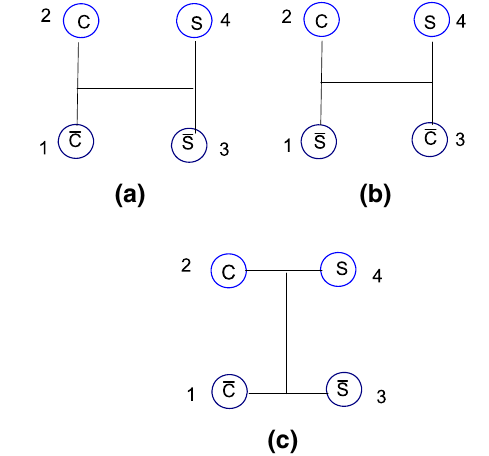
Fig. 1 Two types of configurations in c ¯ cs ¯ s tetraquarks. a and b is the meson–meson configuration, c is